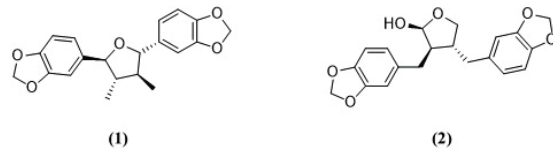
Figure 1 - Structure of the neolignan and lignan isolated from Aristolochia triangularis , galbacin ( 1 ) and cubebin ( 2 ).